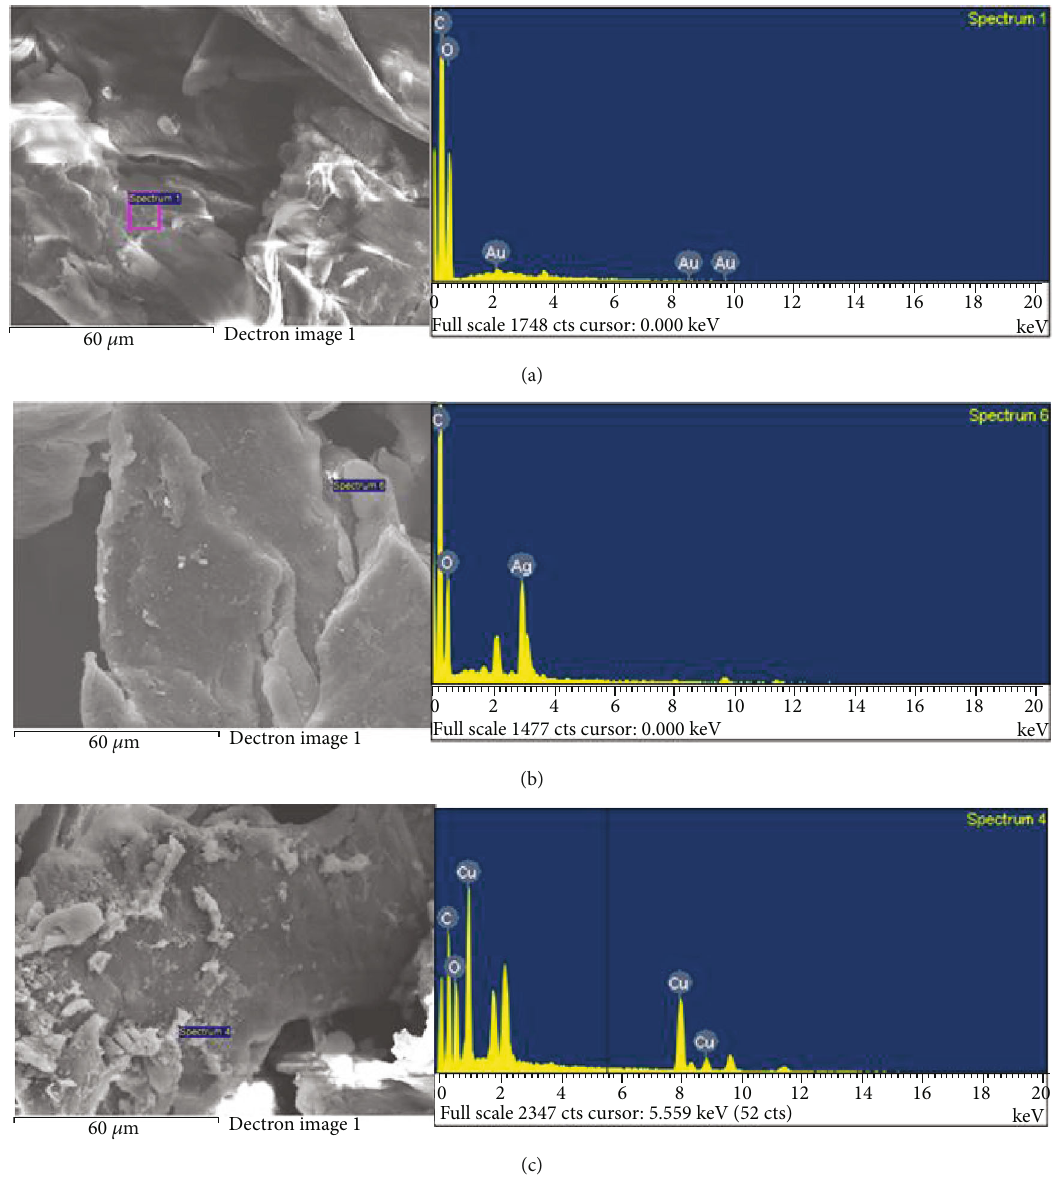
Figure 3: SEM and EDX elemental analysis of gold (a) silver (b) and copper (c) nanoparticles at a concentration of 0.1g/L supported on